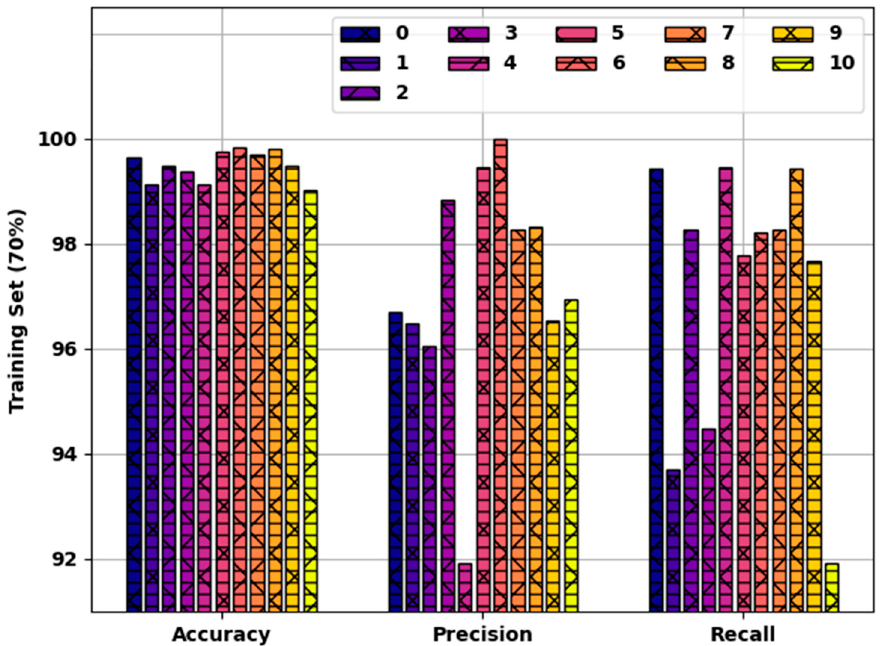
Figure 5. 𝐴𝑐𝑐 (cid:3052) , 𝑃𝑟𝑒𝑐 (cid:3041) , and 𝑟𝑒𝑐𝑎 (cid:3039) analysis of SFODLD-SAC technique on 70% of TRS for classes 0–10.